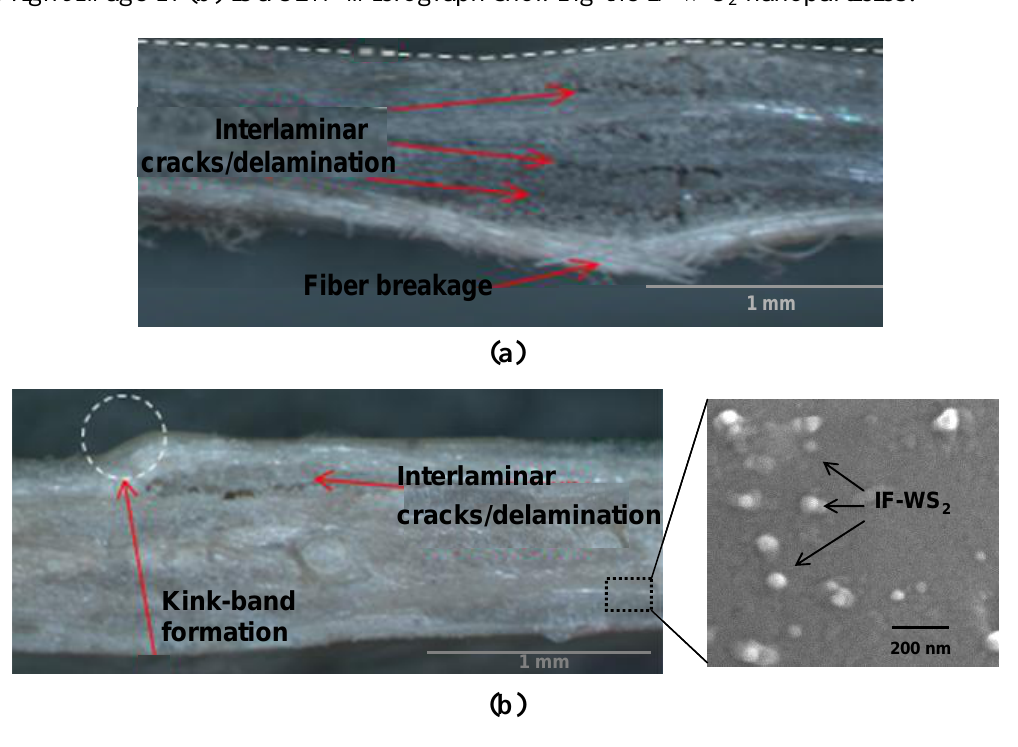
Figure 1. Through-thickness optical microscopy images of failed specimens after short-beam shear tests at 120 °C. ( a ) PPS/CF; and ( b ) PPS/IF-WS The right image in ( b ) is a SEM micrograph showing the IF-WS